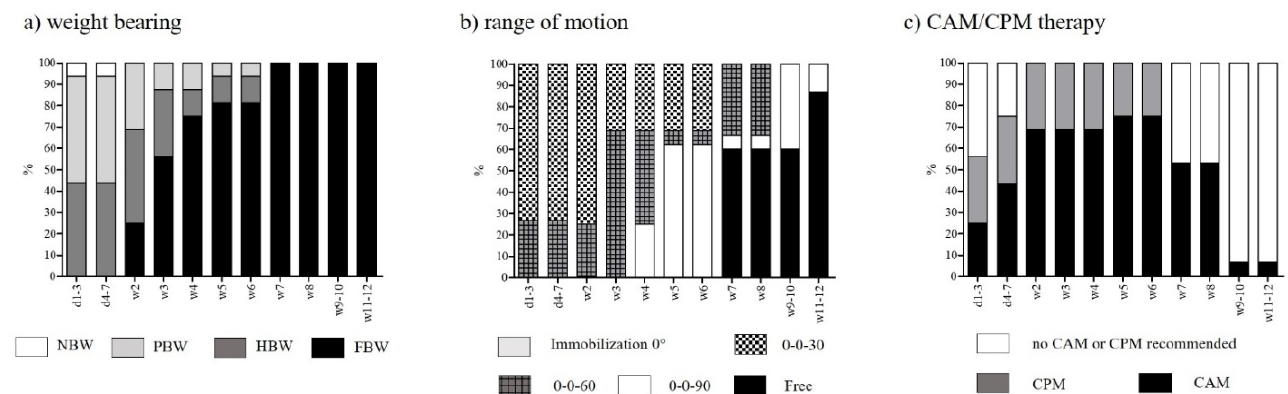
Figure 7. Early rehabilitation phase after retropatellar cartilage repair concerning ( a ) weight-bearing, ( b ) range of motion, and ( c ) motion therapy, expressed in percentage of protocols using them. NBW: no body weight; PBW: partial body weight; HBW: half body weight; FBW: full body weight; CAM: continuous active motion; CPM: continuous passive motion; d: day; w: week.